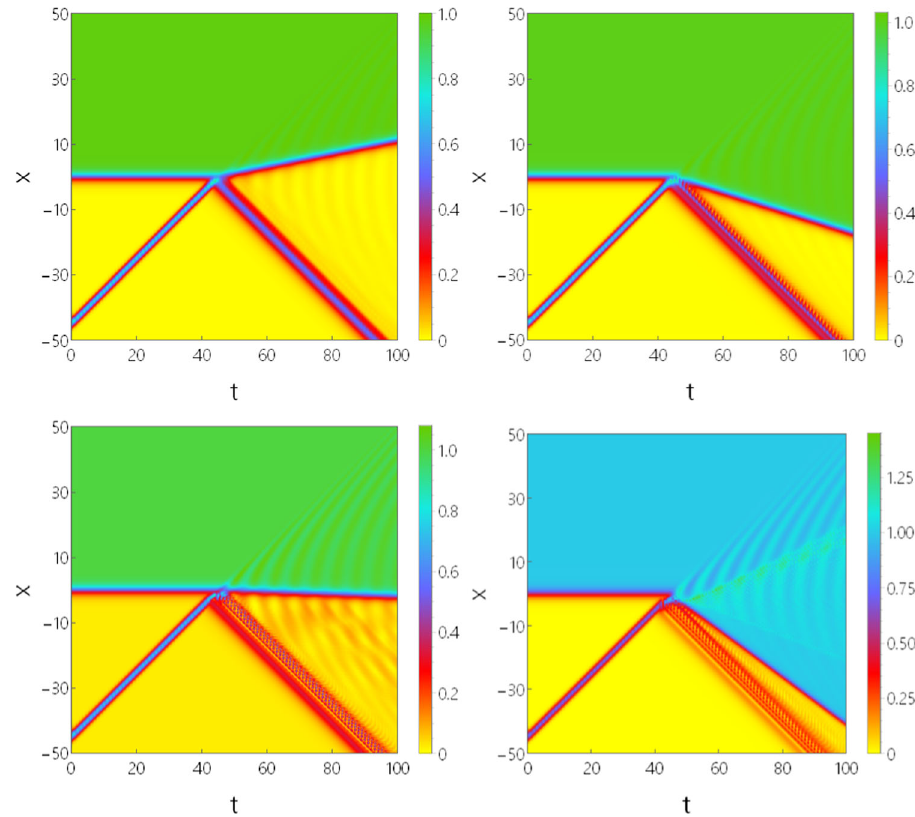
Fig. 6 Collisions between the Gaussian fermionic train (32) and the sine-Gordon kink. The plots represent the profiles of the fermion probability density ¯ ψψ and the field of the kink φ as 2 π functions of the time t for g = 1 (upper row) and g = 3 (bottom row) for the cases of negative (left column) and positive (right column) phases of the train at the moment of